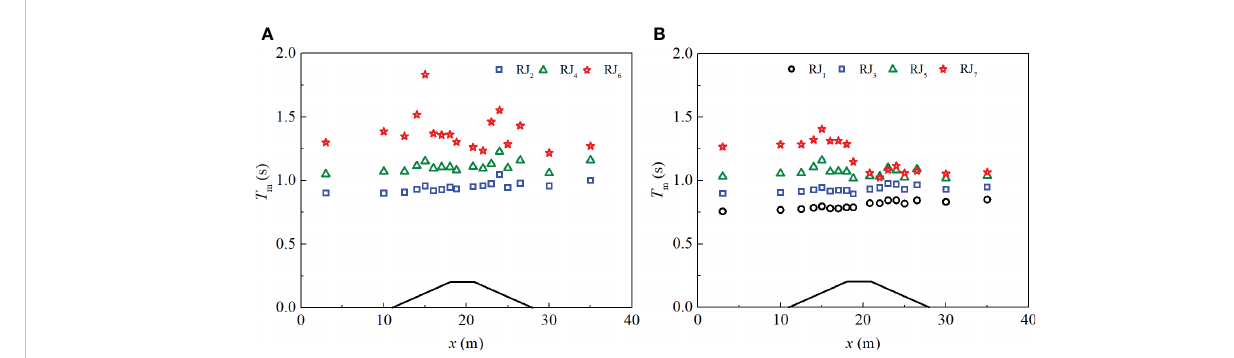
FIGURE 5 The evolutions of the average value for the mean period, T m , for cases (A) with H s = 0.025 m and (B) with H s = 0.05